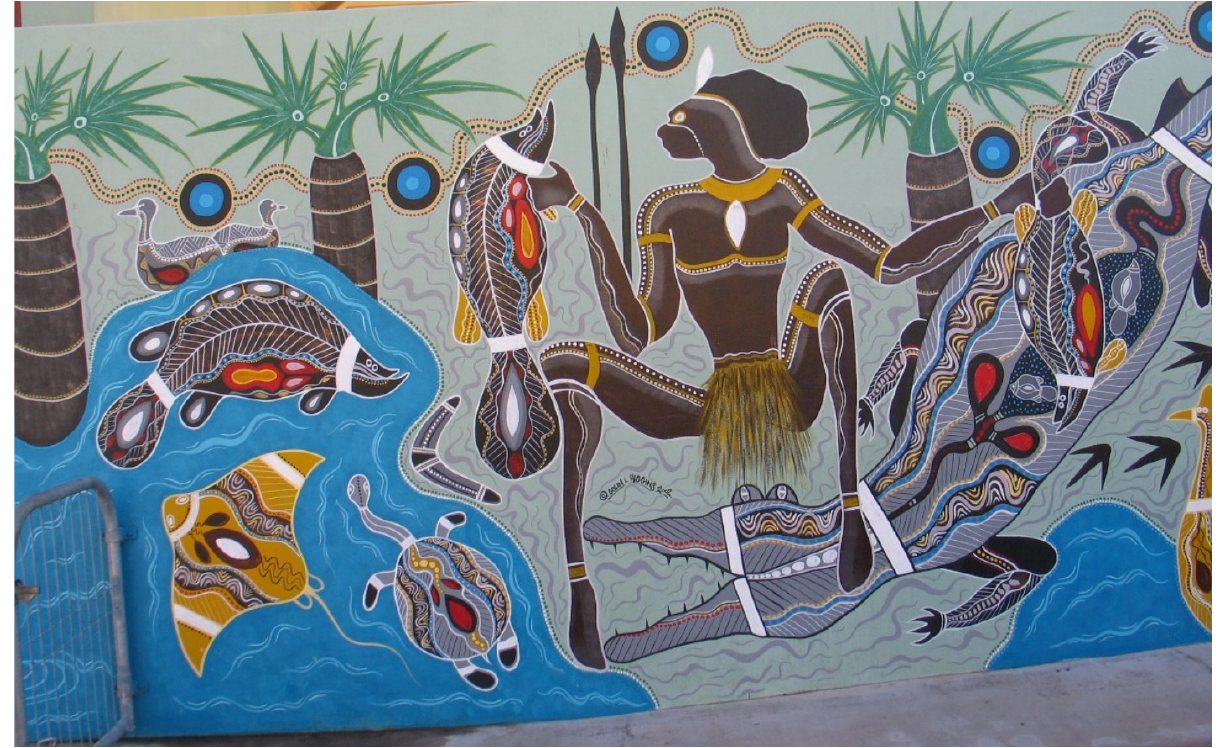
Figure 1. Mural in the community of Kowanyama, Cape York Peninsula, Queensland Australia. Photo Veronica Strang. Some societies, even as they settled and enlarged, retained a focus on nature